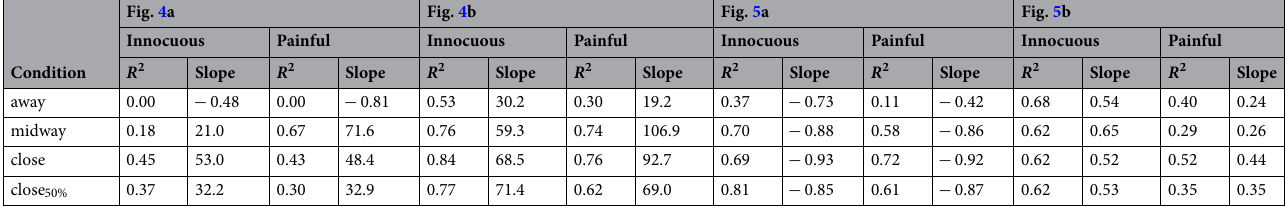
Table 3. Results of linear regression in Figs. 4 and